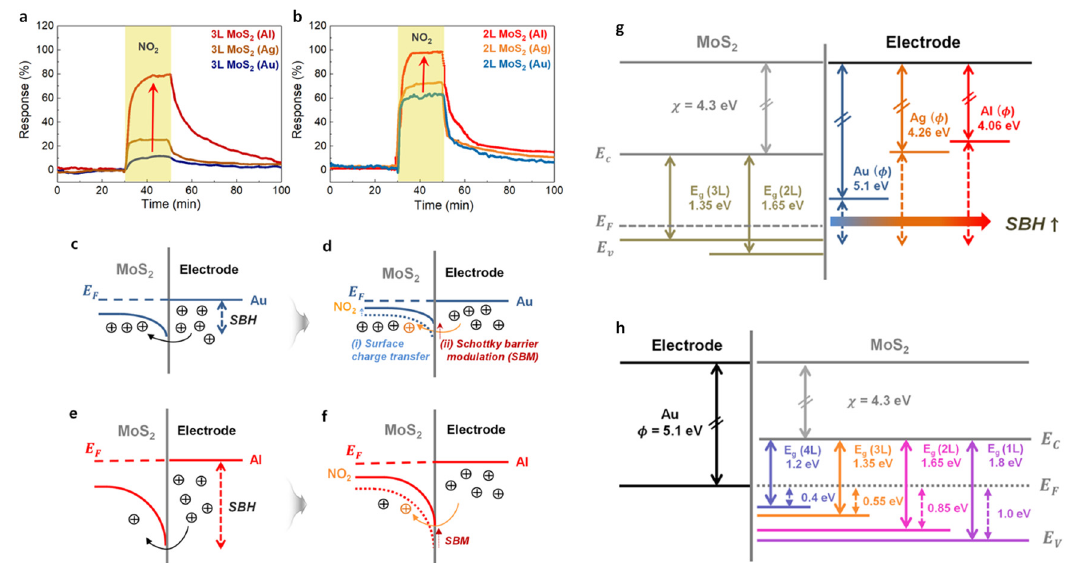
Figure 10. Effect of Schottky barrier height (SBH) engineering on MoS 2 -based sensors for NO 2 detection. ( a , b ) Response towards NO 2 for three different electrodes (metal contact work function) and two different number of MoS 2 layers (semiconductor bandgap). ( c – f ) Schematic of the Schottky barrier for two different electrodes before and after being exposed to NO 2 . ( g , h ) Band alignment for the different combination of electrodes and number of MoS 2 layers before contacting. Adapted from [93]. Copyright by the American Chemical Society (2019).